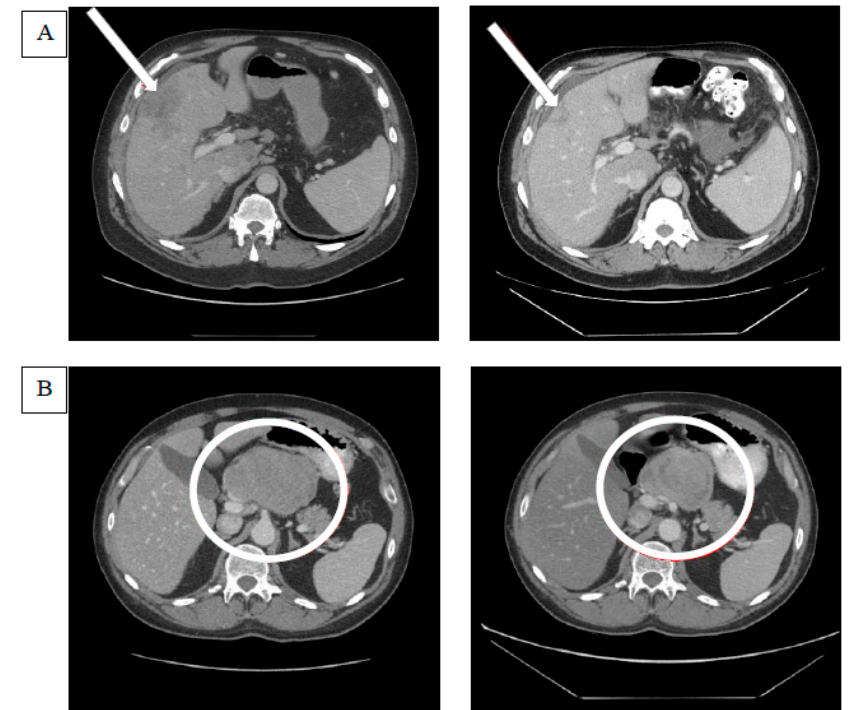
Figure 2. Examples of tumor responses after glembatumumab vedotin treatment. ( A ) The computerized tomography (CT) scan on the left indicates the baseline target lesion in the liver parenchyma that is pointed at by an arrow. The CT scan image on the right demonstrates the shrinkage in the target lesion after glembatumumab vedotin (GV). ( B ) The CT scan on the left demonstrates the target lesion in the porta hepatis lymph node, and the one on the right shows the changes in the lesion after GV. Though the lesion appears to have shrunk in size, the decrease in the lesion’s short axis was not sufficient to meet the response criteria of RECIST 1.1. The target lesion response in the right panel was classified as a stable disease. Table 2. Efficacy analyses.